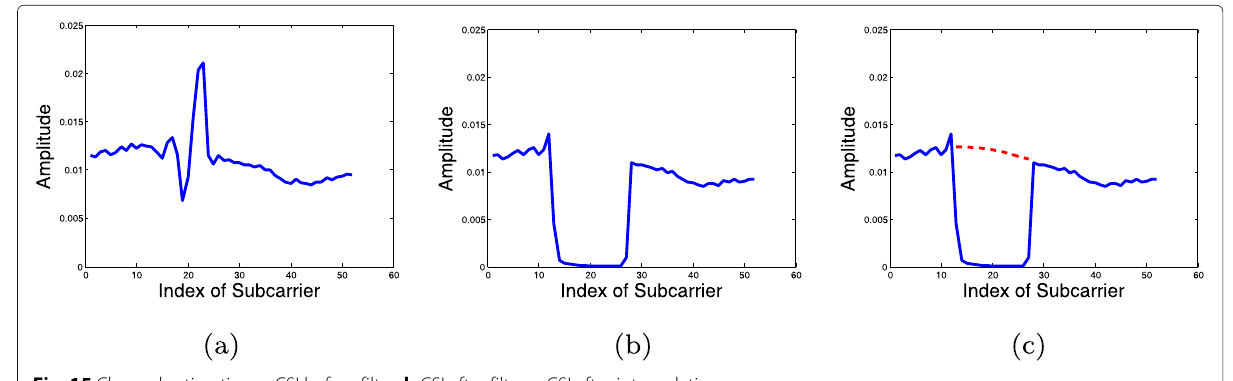
Fig. 15 Channel estimation. a CSI before filter. b CSI after filter. c CSI after